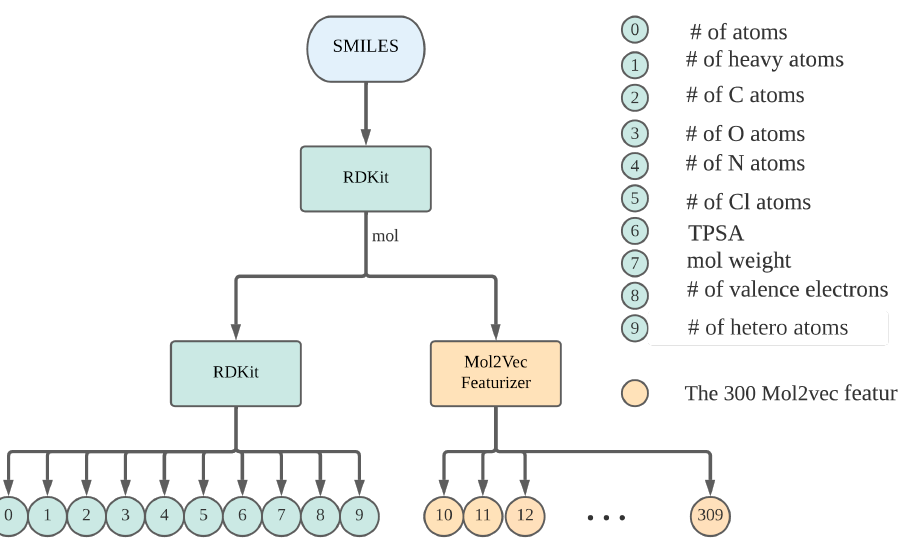
Figure 2. Workflow showing how ten features were generated from RDKit and 300 from Mol2vec for each of the ionic liquids based on their respective SMILES strings.